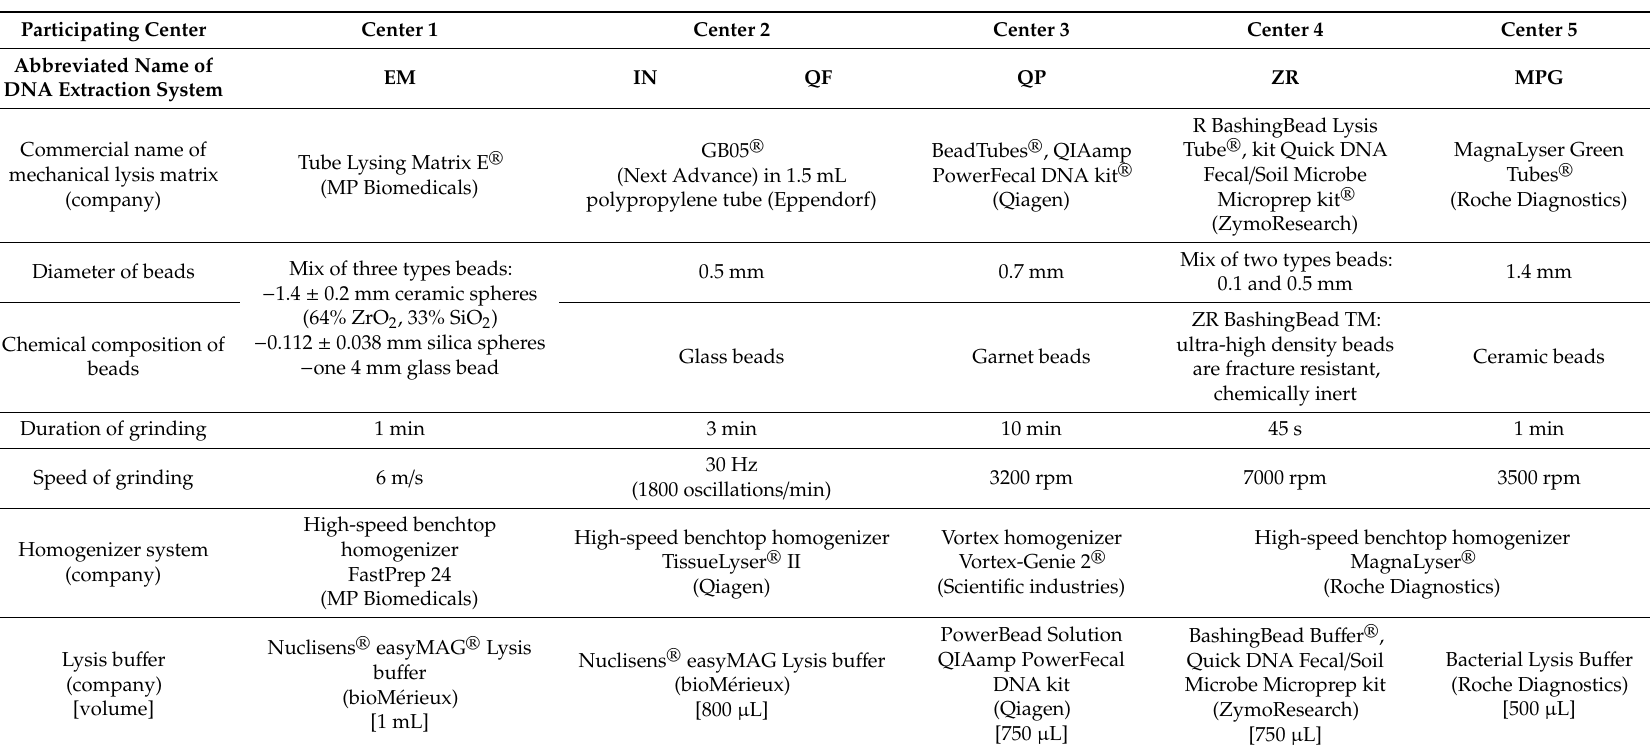
Table 2. Characteristics of mechanical pretreatment according to the DNA pretreatment / extraction protocol used by each participating center. Participating